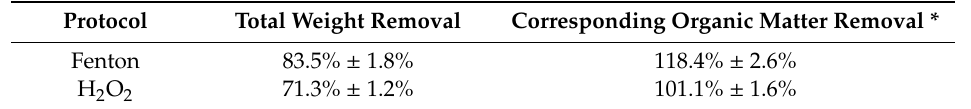
Table 6. Average total and corresponding organic removal e ffi ciencies for the investigated protocols. Results represent the average ± standard deviation for the three sample repetitions.